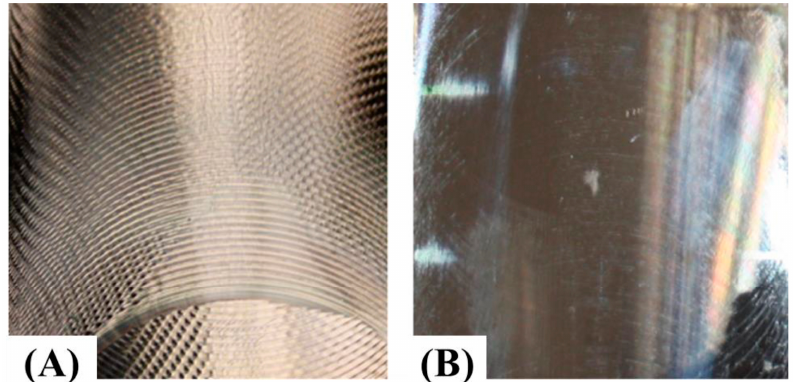
Figure 21. Surface finishing [141]. ( A ) With chatter; ( B ) No